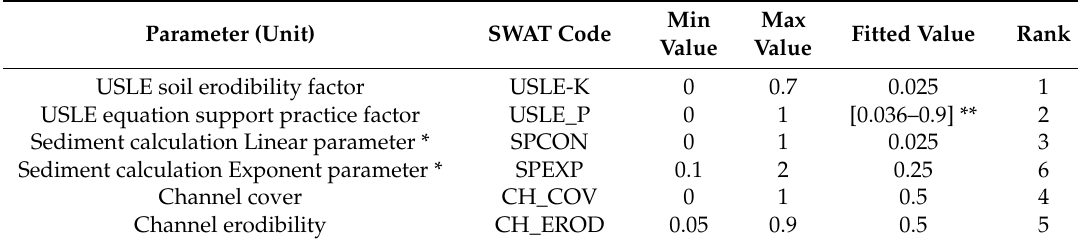
Table 3. Parameters sensitivity in sediment calibration.